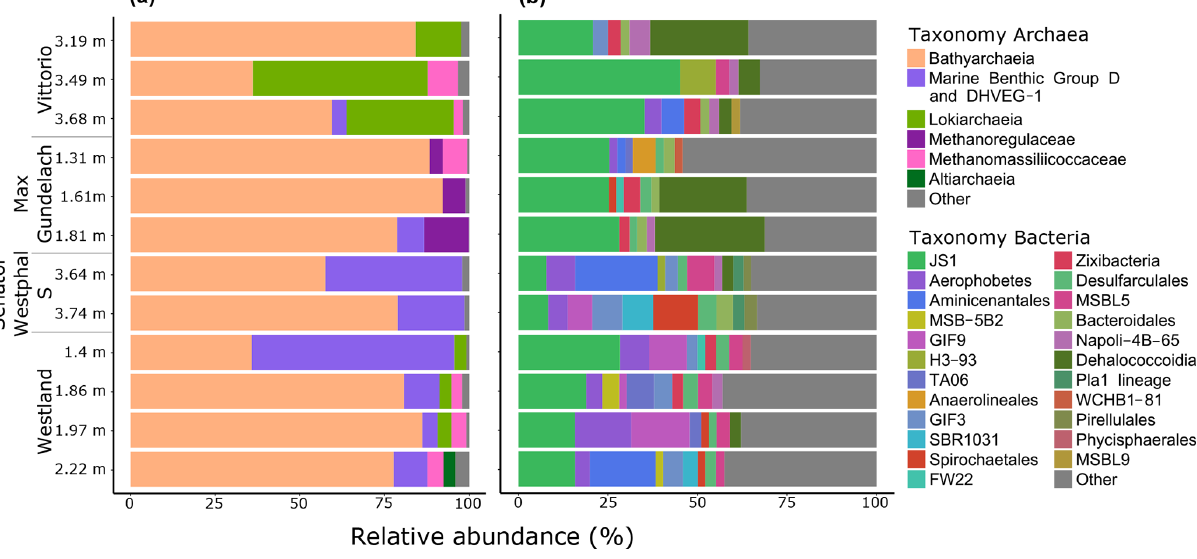
Figure 6. Phylogenetic classification of amplified archaeal (a) and bacterial (b) 16S rRNA genes. The y -axis values indicate the depth beneath seafloor (d.b.s.f.). The maximum taxonomy depth is on family level. Taxonomic groups with < 2% abundance are grouped in